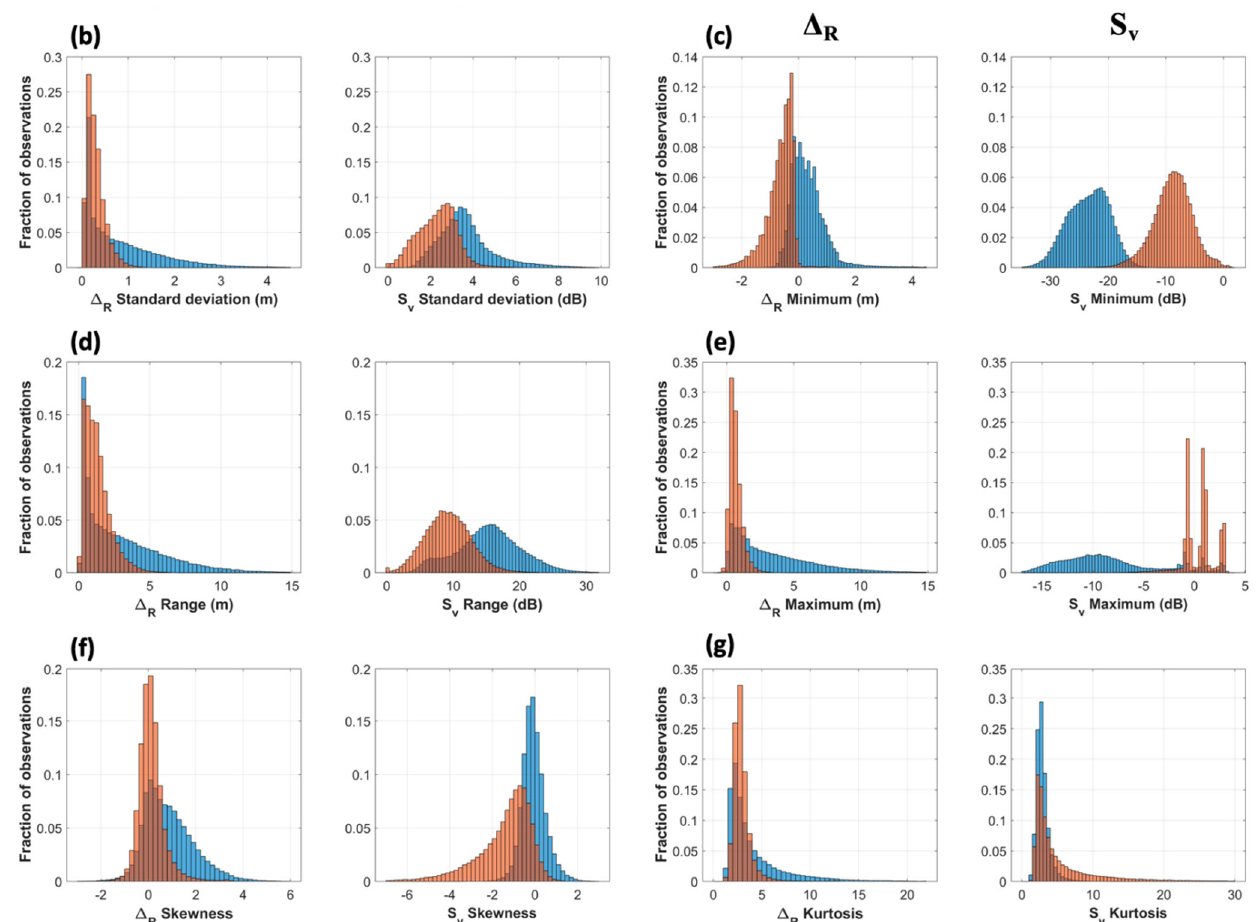
Figure 16. Histograms for each of the statistics provided to the SOM for the six-year AZFP dataset. The statistics used are: mean ( a ), standard deviation ( b ), range ( d ), skewness ( f ), kurtosis ( g ), minimum ( c ), and maximum ( e ) for both ∆ R (left panel of each pair) and S v (right panel of each pair). Ensembles identified by the SOM as open water for the CEO site in the NE Chukchi Sea are plotted in orange, and those identified as ice cover are plotted in blue. Note the different axes for each variable pair.